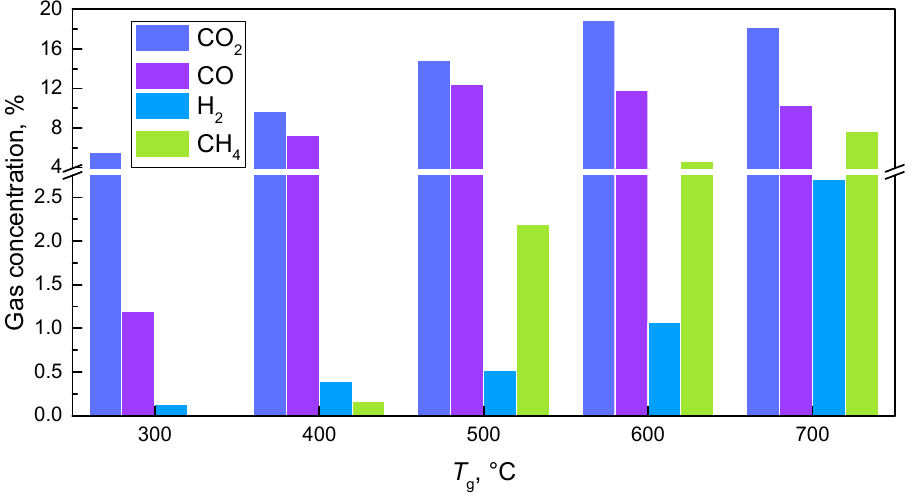
Figure 4. Gas component concentrations in the pyrolysis of biomass (sawdust 25%, straw 50%, leaves 25%) when varying the temperature in the reactor.